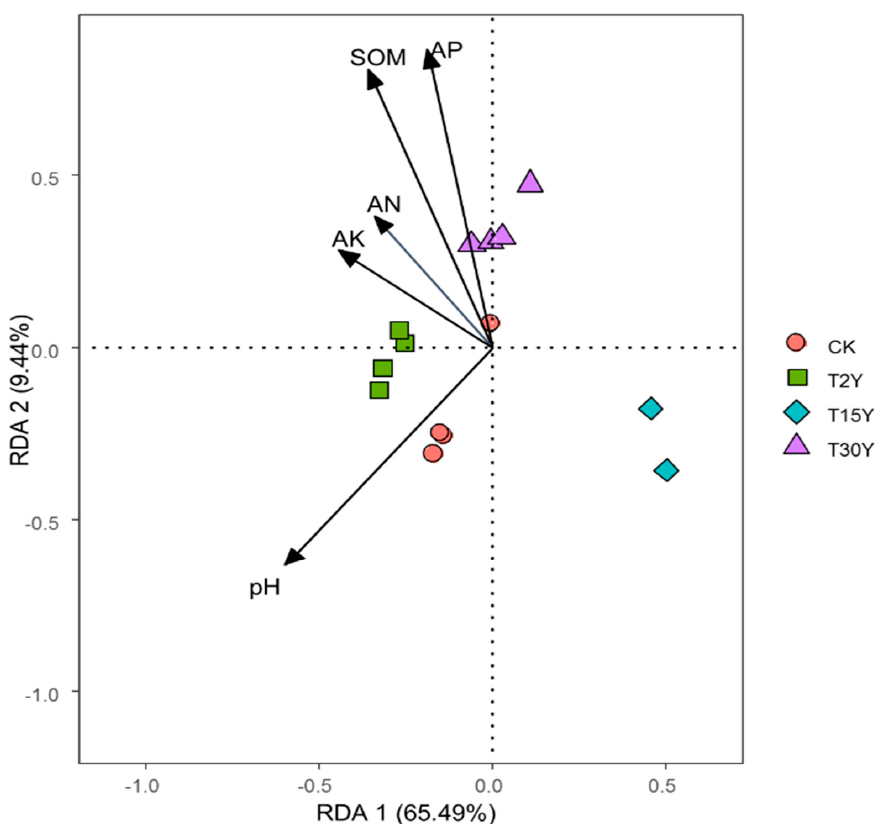
Figure 6. Redundancy analysis (RDA) based on the relative abundances of fungal phyla and soil attributes ((pH, SOM, AN, AP, and AK) for individual samples derived from the control and different age monoculture tea fields. CK, T2Y, T15Y, and T30Y represent tea fields with 0, 2, 15, and 30 years of continuous cropping history, respectively. Table 3. Pearson’s correlation between soil properties and abundant taxa of fungi (phyla, genera, and species) in control and different age monoculture tea fields.